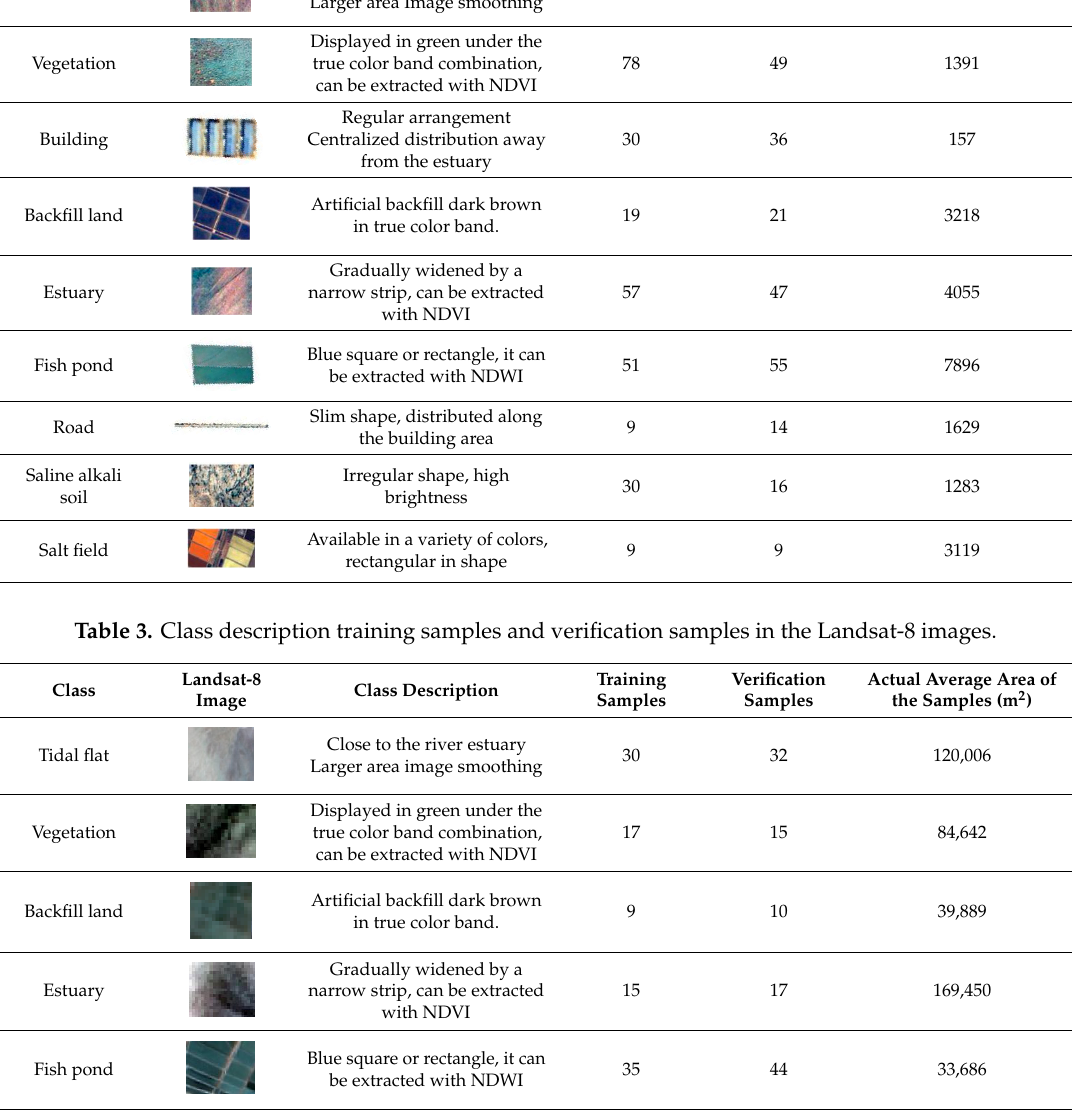
Table 2. Class description training samples and verification samples in the Worldview-2 images.